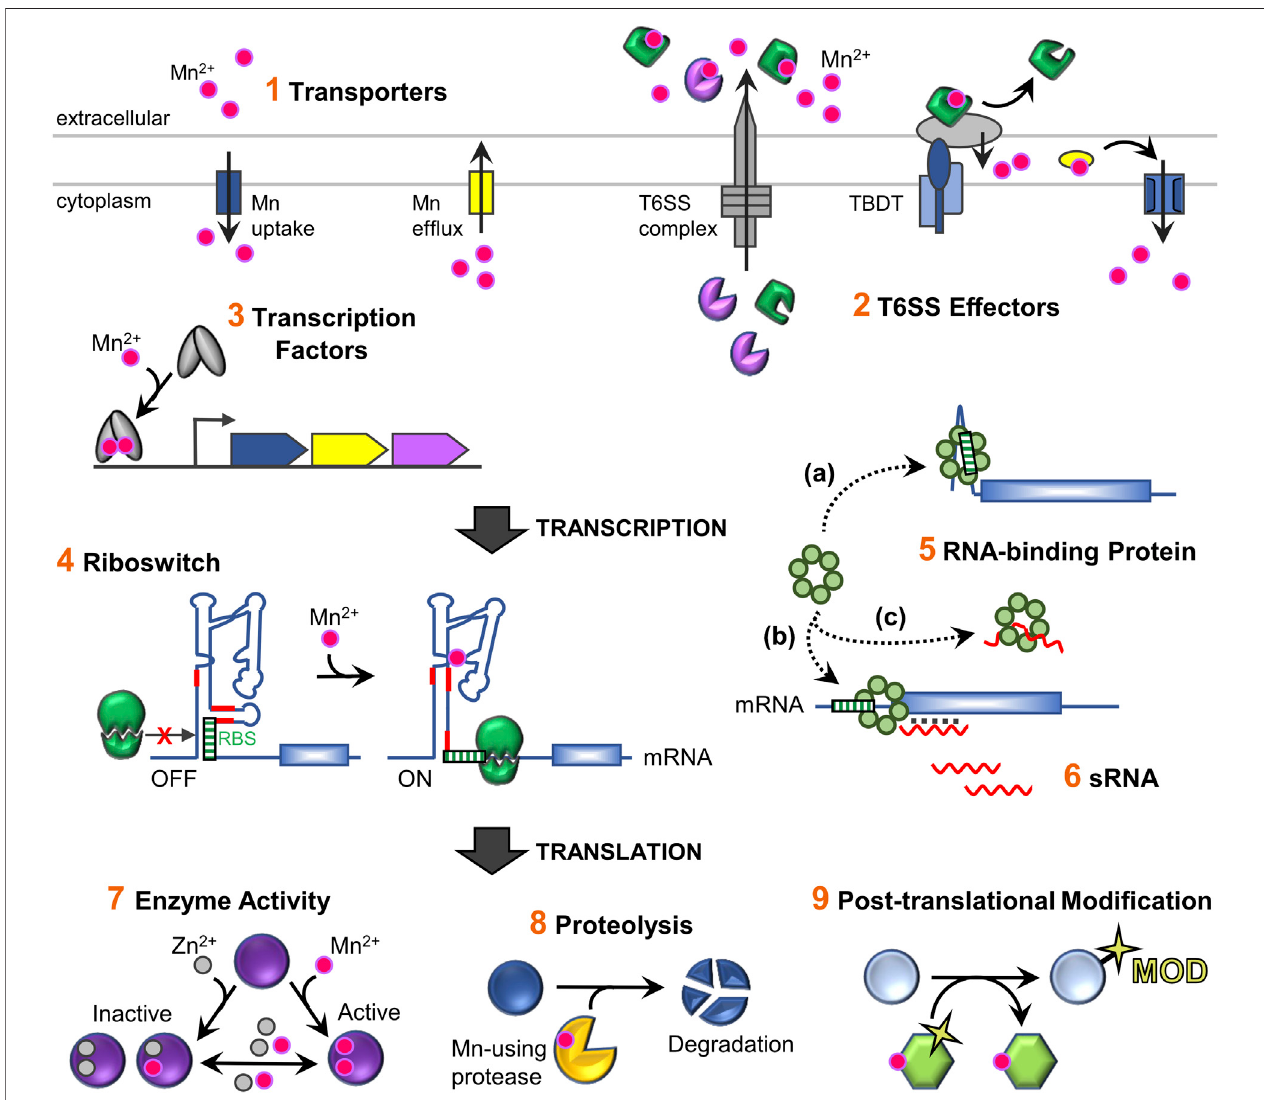
FIGURE 2 | Schematic overview of the regulatory network for maintaining Mn homeostasis and its usage in bacterial cells. Total intracellular levels of Mn are controlled by 1) regulated import and ef fl ux through dedicated Mn-speci fi c transporters located in the inner membrane (refer to Figure 1A for representative transporter classes).Inaddition,2)extracellularbindingproteins( T6SSeffectorproteins )cancaptureextracellularMnanddeliverittootheruptakemachinery(Yangetal.,2021). Mn- sensing regulatory factors control expression of Mn homeostasis genes, primarily encoding transporters, via conformational changes when bound to Mn. These include 3) protein transcription factors that transcriptionally regulate gene expression, as well as 4) RNA-based Mn-sensing riboswitch elements which provide post- transcriptional regulation via altering accessibility of the ribosome binding site (RBS) or an anti-termination event that allows transcription read-through of the coding region of the mRNA (not shown). Other post-transcriptional regulatory mechanism that affect mRNA stability and/or translation include 5) RNA-binding proteins (RBPs) such as CvfD (Sinha et al., 2020) and 6) sRNAs such as RsaC (Lalaouna et al., 2019). RBPs can act directly on mRNAsby binding to motifs present in the mRNA and/or enable sRNAs to base-pair with a mRNA. It is not currently known whether CvfD and RsaC require other factors to mediate their effects. In contrast to riboswitches, sRNAs do not typically directly sense environmental signals by binding ligands, but instead are expressed under speci fi c environmental conditions (e.g., high or low Mn levels). Fluctuating intracellular Mn levels serve as an important role post-translationally , after nascent Mn-using proteins are synthesized. 7) The intracellular labile metal pool can in fl uence the metallation status and activity of Mn-enzymes, such as PhpP, CspB, and Pgm (Martin et al., 2017b; McFarland et al., 2021). Such enzymes are activewhenboundtoMn,butbecomeinactivewithlossofmetalorwhenreplacedwithZn;reducedactivityisobservedwithothermetalcations.Thisprocessmightalso be aided by metal chaperone delivery factors during Mn de fi cient bacterial growth (not shown). 8) Metal-dependent protein factors, such as proteases, can directly control proteinlevels ,aswhentheYqgPproteasedegradestheMgtransporterMgtA(Beganetal.,2020).OtherexamplesincludeMn-bindingtranscriptionfactors(PerR andIrr)thatbecomeoxidizedwhenboundtoFeorheme,whichleadstotheirdegradation(notshown)(LeeandHelmann,2006;AhnandBaker,2016;Nametal.,2020). 9) Activated Mn-enzymes YdiU and PhpP may cause global physiological responses by modulating the activities of non-metal binding proteins via post-translational protein modi fi cations , UMPylation and dephosphorylation, respectively (Martin et al., 2017b; Yang et al., 2020). Mn ions are designated as pink spheres; Zn as grey